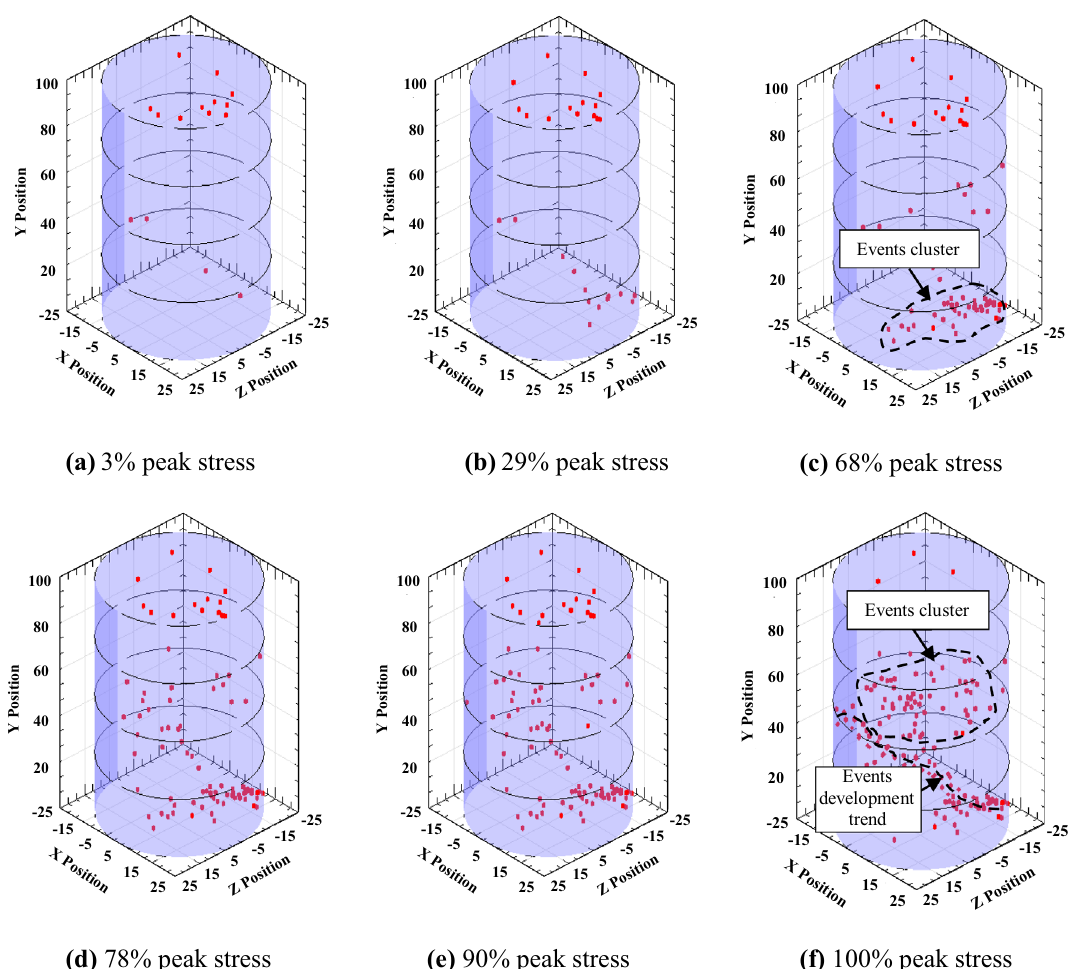
Fig. 10 AE events localization results for specimen